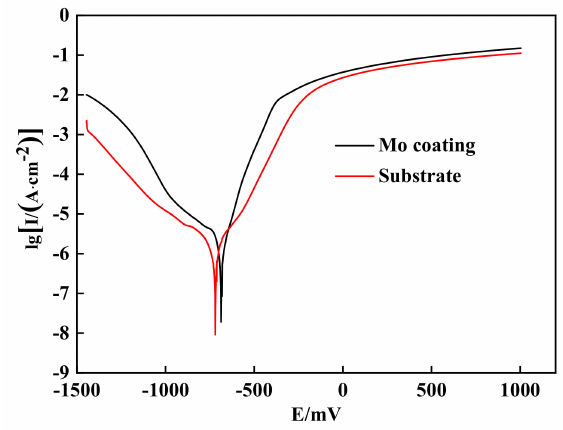
Figure 19. Polarization curves of substrate and